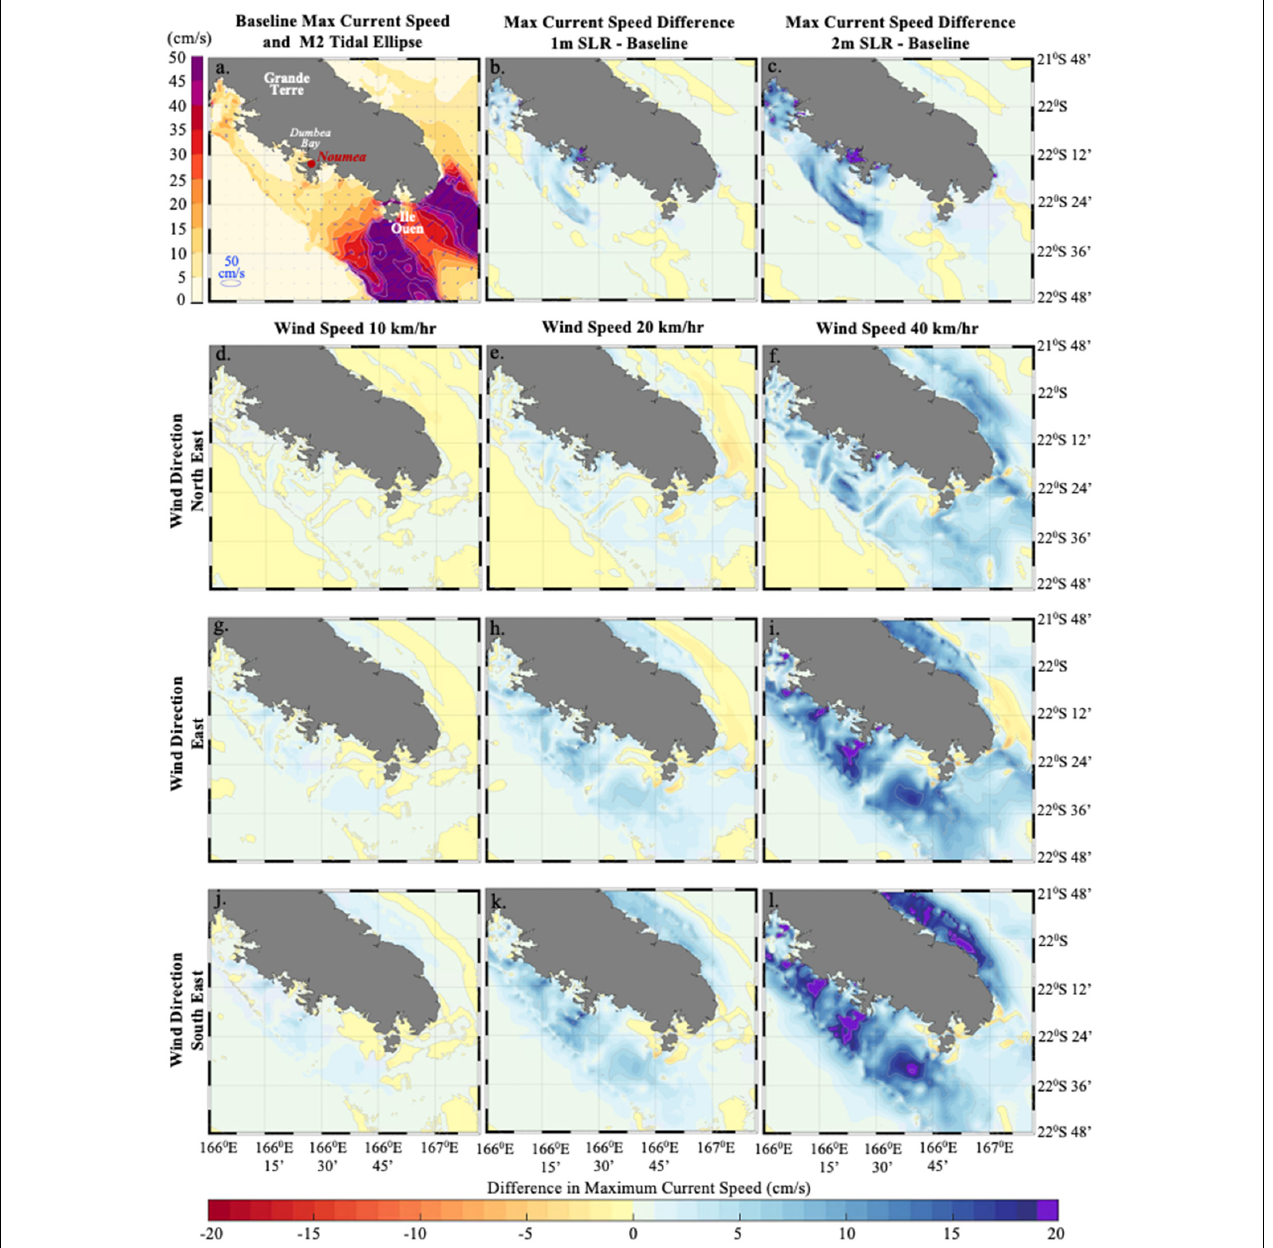
FIGURE 4 | Baseline maximum depth-averaged current speeds (cm/s) for southern Grande Terre, New Caledonia, shown underlying M2 tidal ellipses, with white isolines at 5 cm/s intervals (a) . Change in maximum depth-averaged current speeds (cm/s) under 1 m SLR (b) and 2 m SLR (c) . Change in maximum depth-averaged current speed (cm/s) under 10 km/h (d) , 20 km/h (e) , and 40 km/h (f) northeast winds. Change in maximum depth-averaged current speed under 10 km/h (g) , 20 km/h (h) , and 40 km/h (i) east winds. Change in maximum depth-averaged current speed under 10 km/h (j) , 20 km/h (k) , and 40 km/h (l) southeast winds. Light grey isolines (b–l) indicate 5 cm/s intervals. Latitudes are displayed to the right of panels (c,f,i,l) . Longitude for all panels are displayed below panels (j–l)